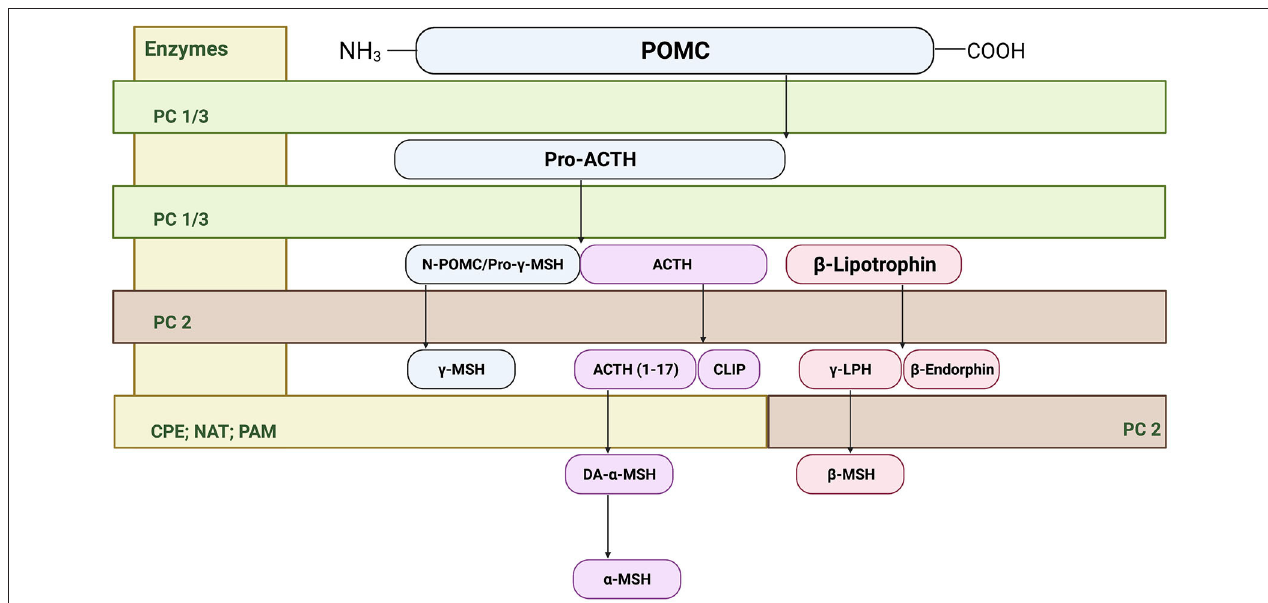
FIGURE 1 | Cleavage of precursor protein pro-opiomelanocortin (POMC). Pro-hormone convertase 1/3 (PC1/3) cleaves POMC into pro-adrenocorticotropic hormone (Pro-ACTH) and β -lipotropin. PC 1/3 further processes pro-ACTH into ACTH where proconvertase 2 (PC 2) then sequentially cleaves ACTH to ACTH (1–17) and corticotropin-like intermediate peptide (CLIP). From there, carboxypeptidase E cleaves the basic amino acid residues of ACTH (1–17) allowing amidation by peptidyl α -ami-dating monooxygenase (PAM) to form des-acetyl- α -MSH (DA- α -MSH), where then n-acetyltransferase (NAT) acetylates DA- α -MSH into the mature α -MSH. PC2 also cleaves the N-terminal portion of POMC fragement/pro- γ -melanocyte stimulating hormone (MSH) into γ -MSH. Finally, β -lipotropin is processed into the endogenous opioid β -endorphin and γ